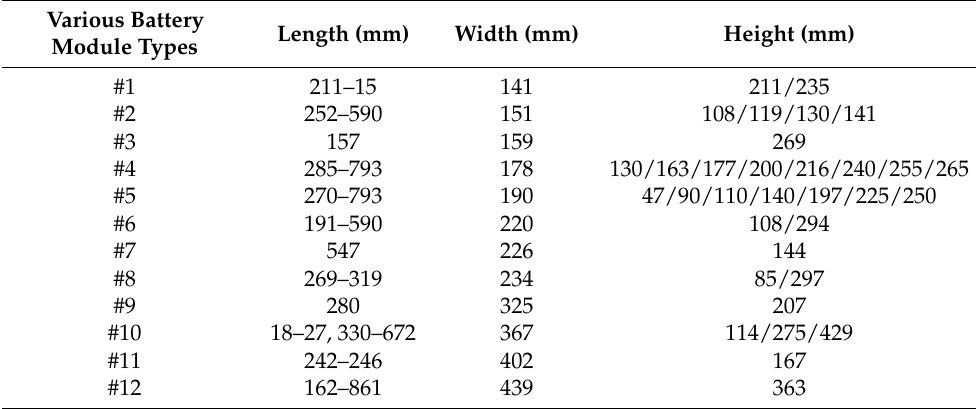
Table 2. GB/T 34013–2017 electric vehicle various battery module